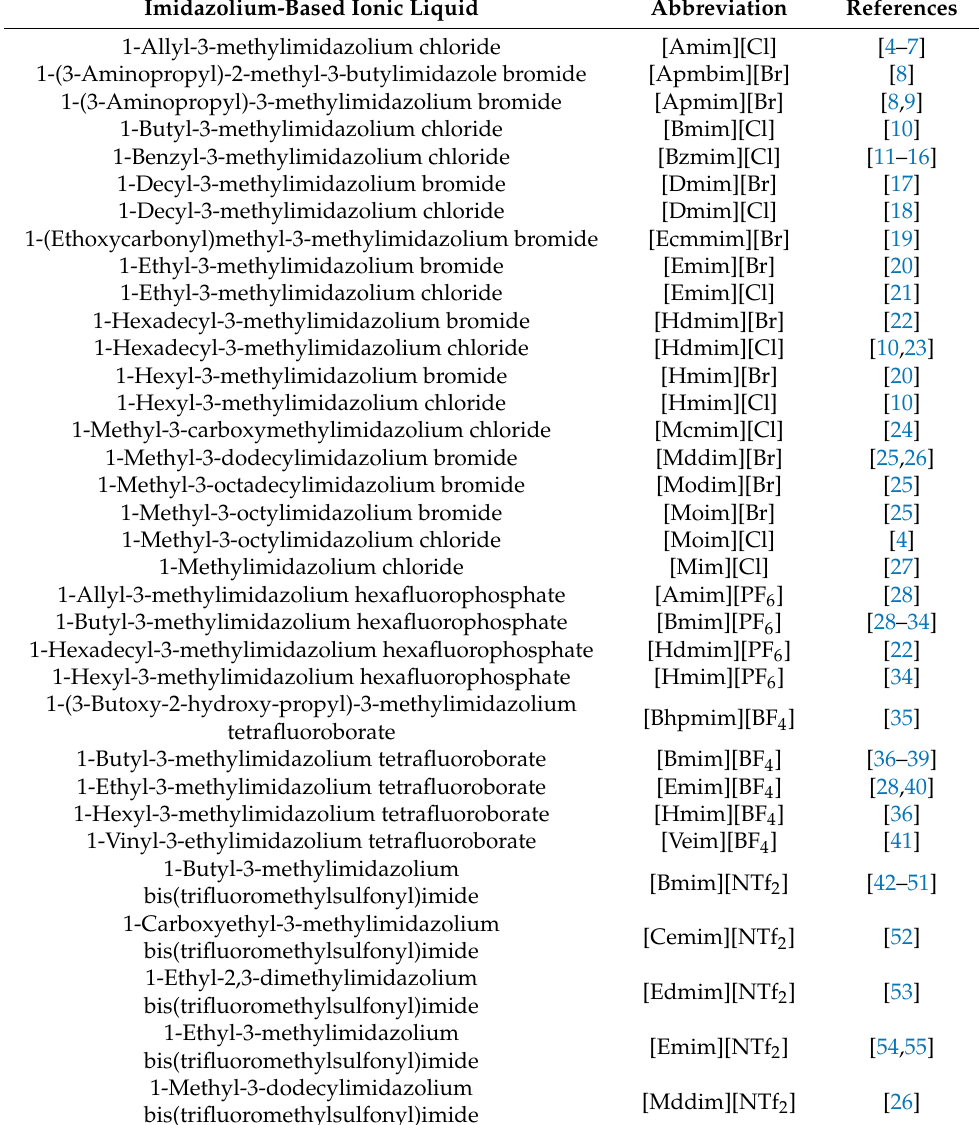
Table 1. Examples of imidazolium-based ionic liquids employed for modification of